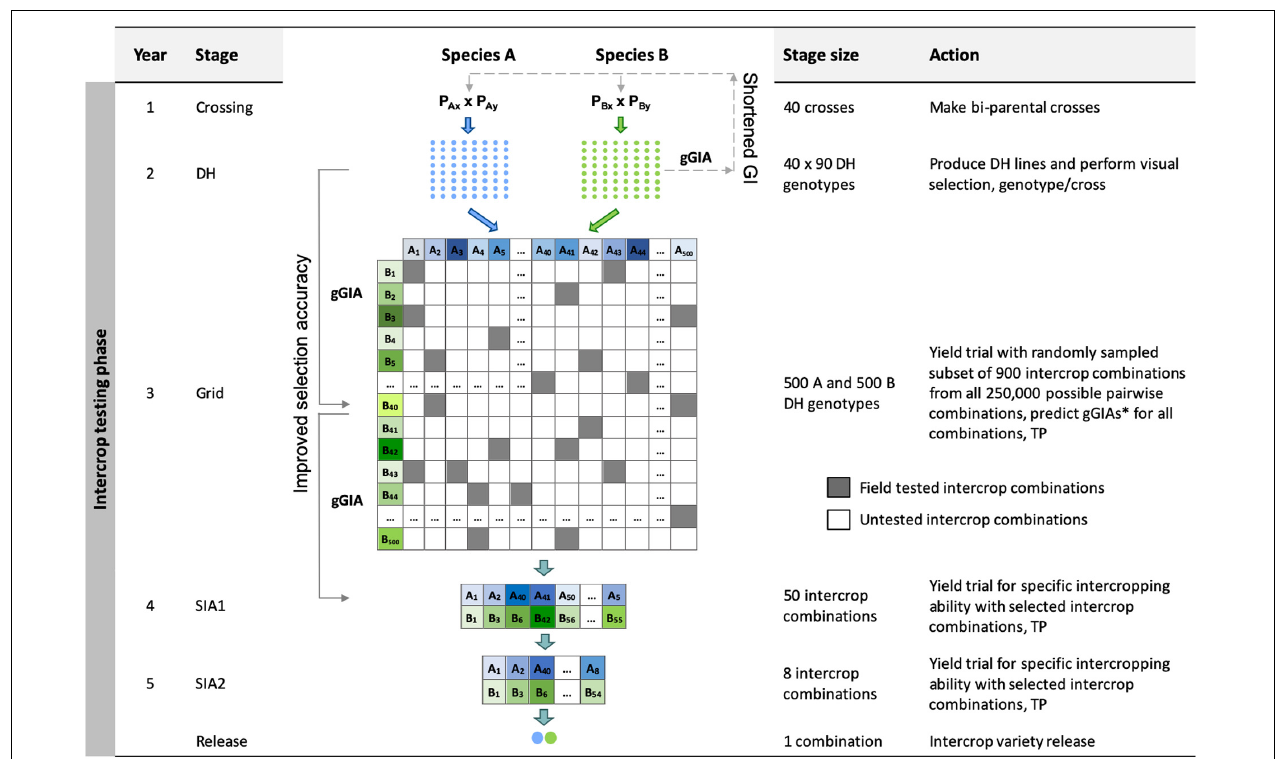
FIGURE 2 | Schematic overview of the Grid genomic selection breeding program (Grid-GS). gGIA, genomic-predicted general intercropping ability; TP, denotes stages in which genotypic and/or phenotypic records are collected; DH, the doubled haploid stage; Grid, the grid stage; SIA 1 and 2, the specific intercropping ability stages 1 and 2. Solid line with arrow represents increased selection accuracy based on gGIAs and dashed line with arrow represents shortened generation